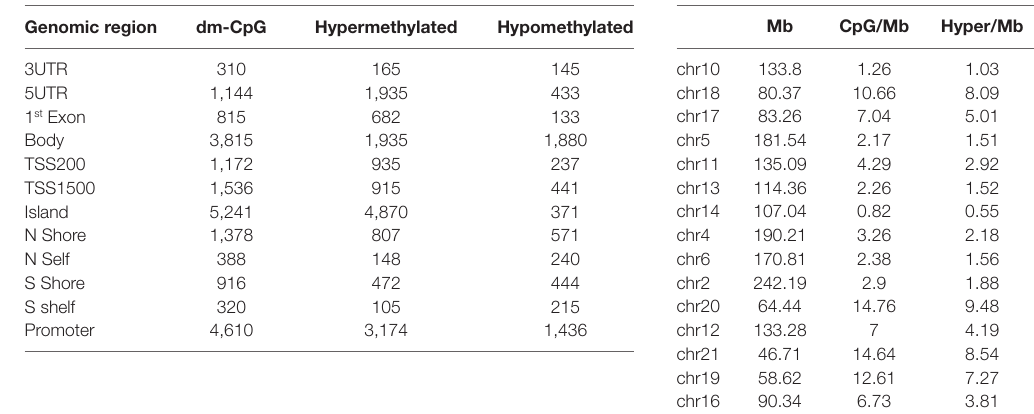
( Table S3 ). Examples of DMRs showing contrasting methylation patterns between normal and tumor samples on chromosome 9 and chromosome 2 are presented in Figure S5 .